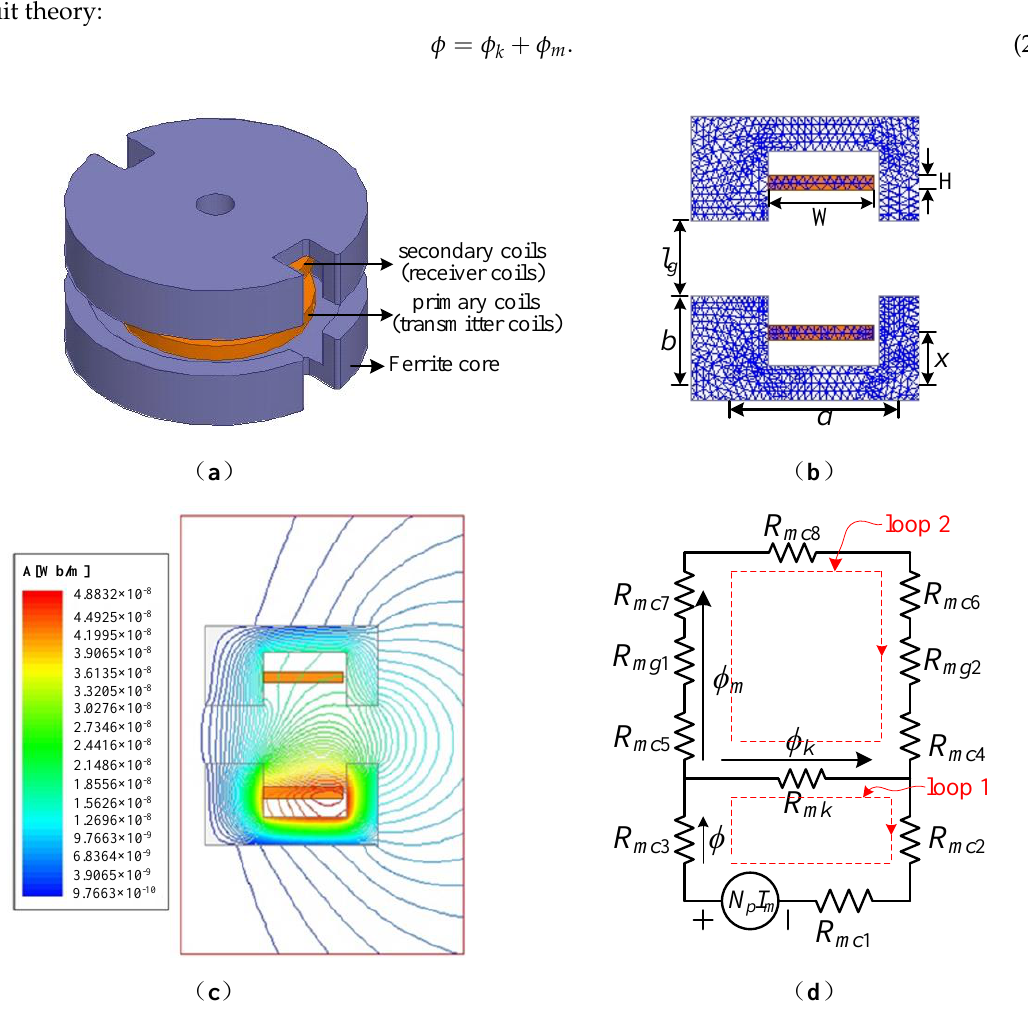
Figure 4. Structure and magnetic circuit of the coupler. ( a ) Structure; ( b ) 2D finite element model; ( c ) Magnetic flux distribution; ( d ) Magnetic circuit